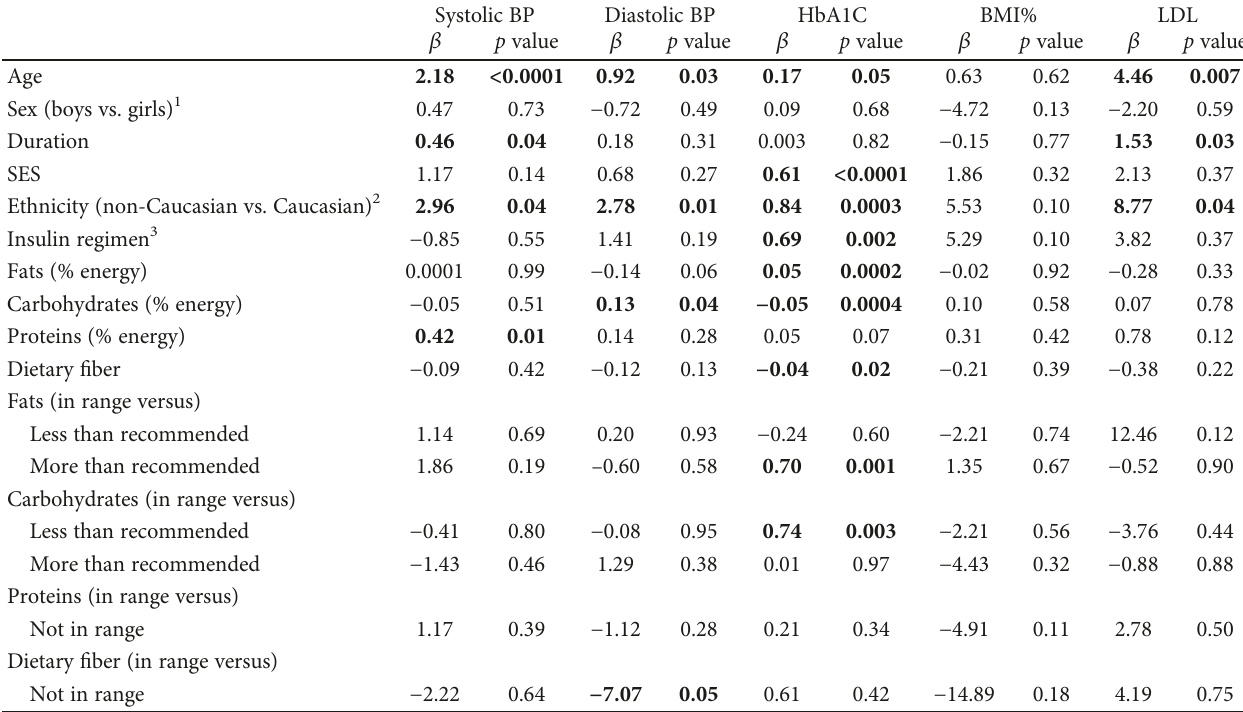
Table 3: Bivariate associations among demographic and nutritional variables and all health measures. Systolic BP Diastolic BP HbA1C